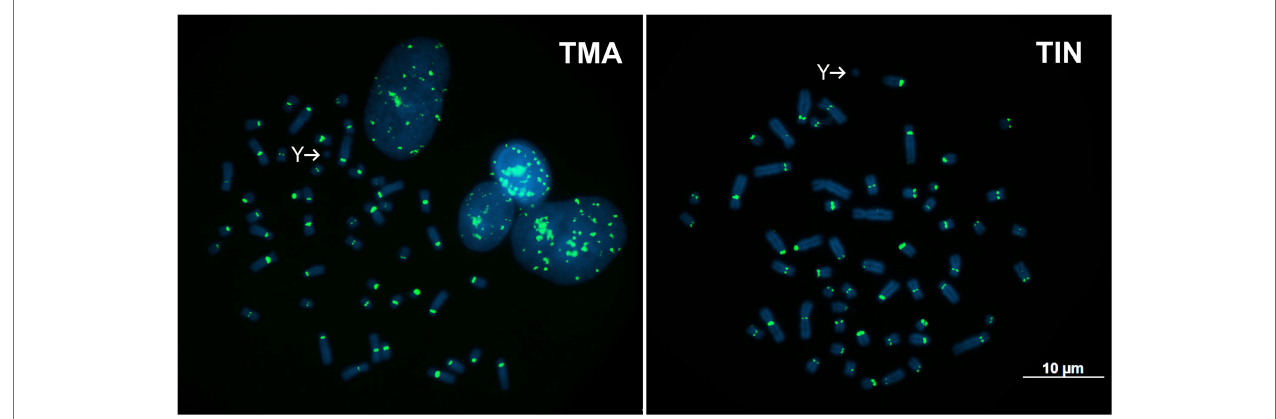
FIGURE 2 | Metaphases of T. manatus (TMA) and T. inunguis (TIN) after FISH with the TMAsat probe. Y chromosomes without signals of TMAsat are